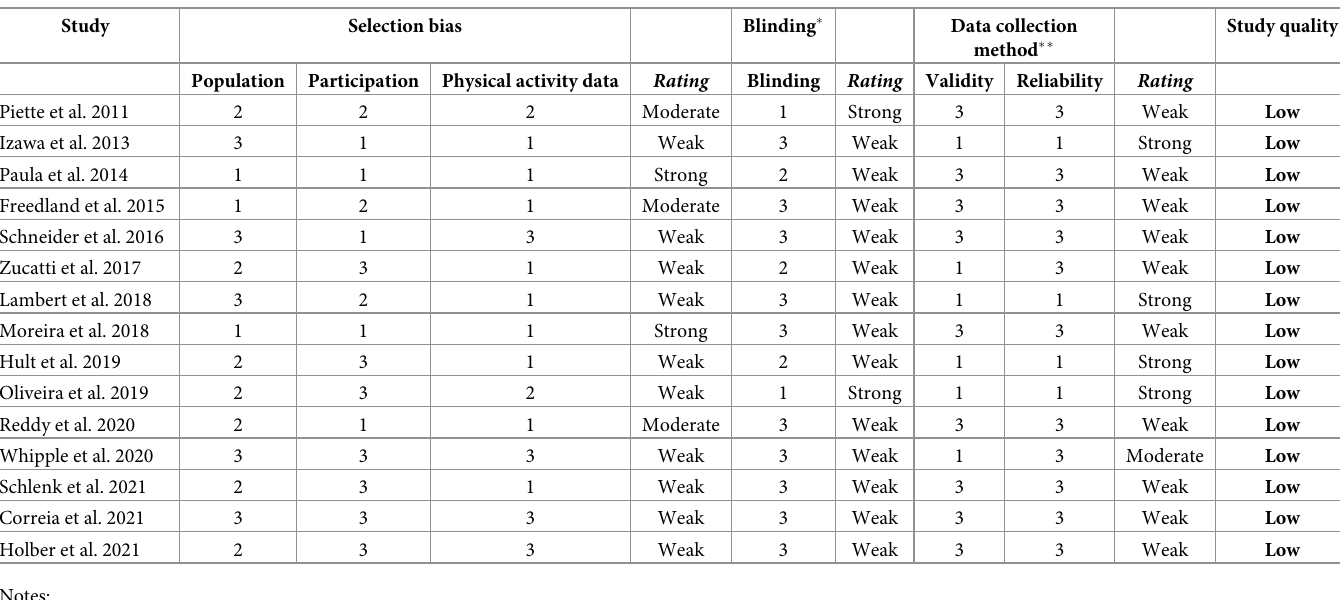
Table 3. Risk of bias assessment of included